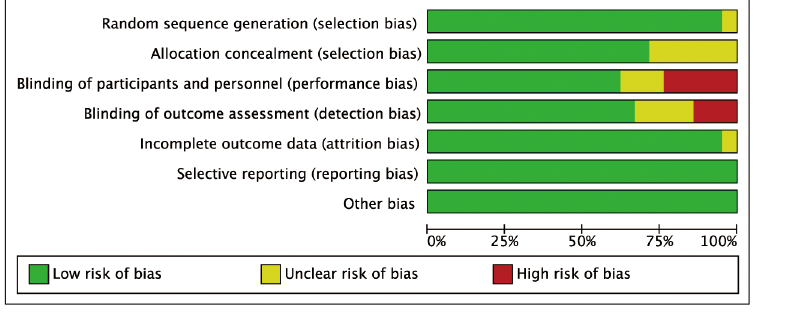
Fig 3. Risk of bias